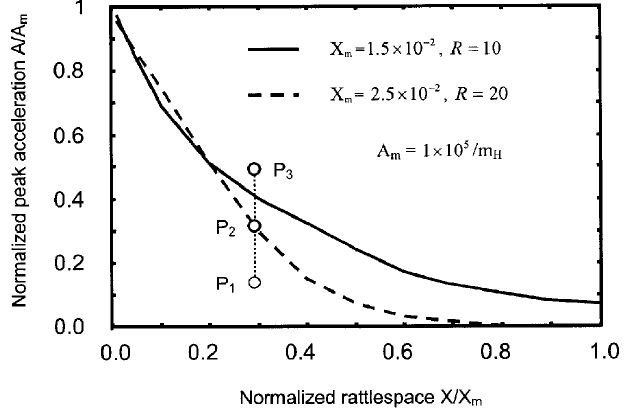
Fig. 12. Limiting performance